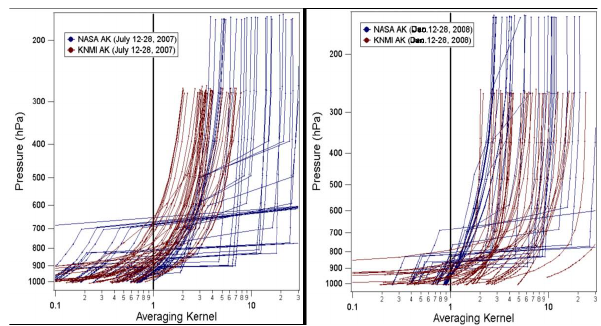
Fig. 13. A comparison of OMI tropospheric NO 2 averaging kernel profiles for Seattle, applied to the AIRPACT results for July 2007 (left) and January 2008 (right). The NASA averaging kernels were output explicitly from Bucsela’s code using AIRPACT pressure lay- ers while the KNMI kernels were converted to the AIRPACT pres- sure layers using a cubic-spline interpolation at 2hPa spacing. The vertical extent of the KNMI averaging kernel is one layer less than that derived from Bucsela’s code. The top tropospheric layer of NO 2 in the model is multiple orders of magnitude less in molecular abundance than the surface layers, so the contribution is insignifi- cant to the total tropospheric column. However, it is the portion in the profile with the most instrument sensitivity, which results in the largest averaging kernel value.